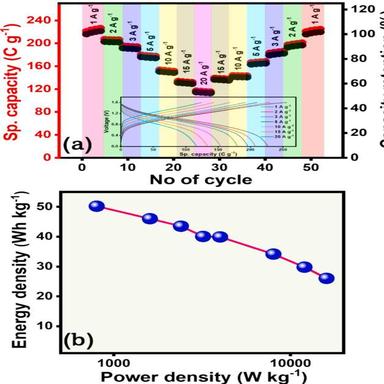
(a) Specific capacity and retention as a function of cycle number, and current with inset showing the voltage as a function of specific capacity for different currents (b) Ragone plot with energy density plotted against power density.